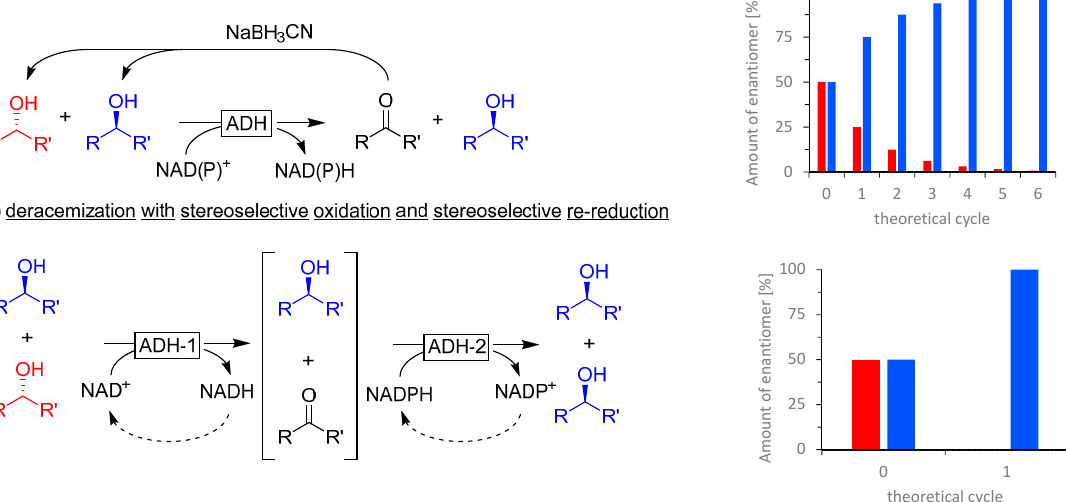
Scheme 25. Deracemization of alcohols combining ( a ) stereoselective kinetic resolution of the alcohol and non-selective re-reduction back into the racemate and ( b ) stereoselective oxidation combined with stereoselective